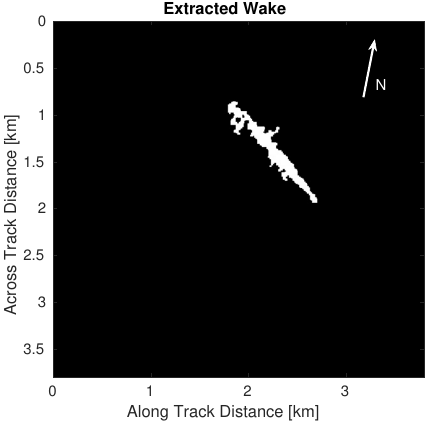
Figure 18. Feature delineated by the wake extraction